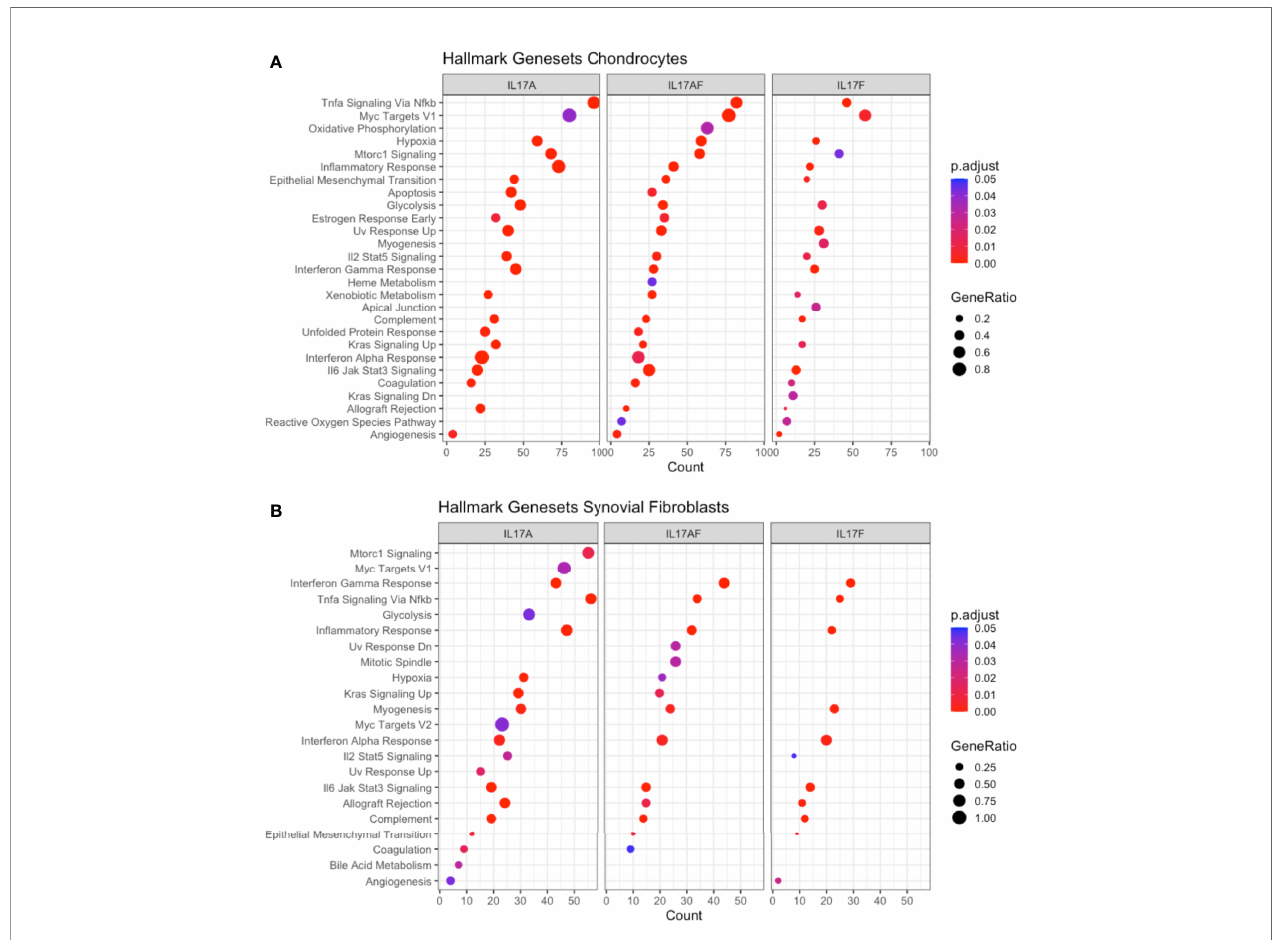
FIGURE 3 | Results from GSEA Hallmark pathway analysis. Dot plots representing the changes in GSEA hallmark pathways after IL-17A, IL-17AF, and IL-17F treatment in (A) chondrocytes and (B) synovial fi broblasts, including the gene ratio (ratio of DEG over the total number of genes in pathway), gene count (number of DEG in pathway), and the adjusted